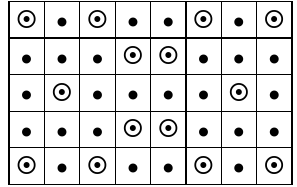
Figure 4: 8×5 grid of dots. All dots were displayed as  to participants. The  around the dots only serve to indicate the dots that were used for the